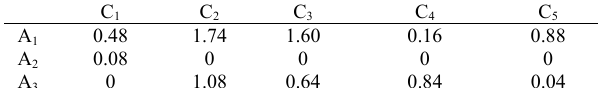
Table 8. The separation measures of individual criteria to their positive ideal solution.